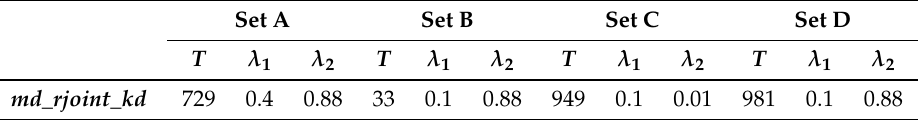
Table 4. Hyperparameters determined from Bayesian